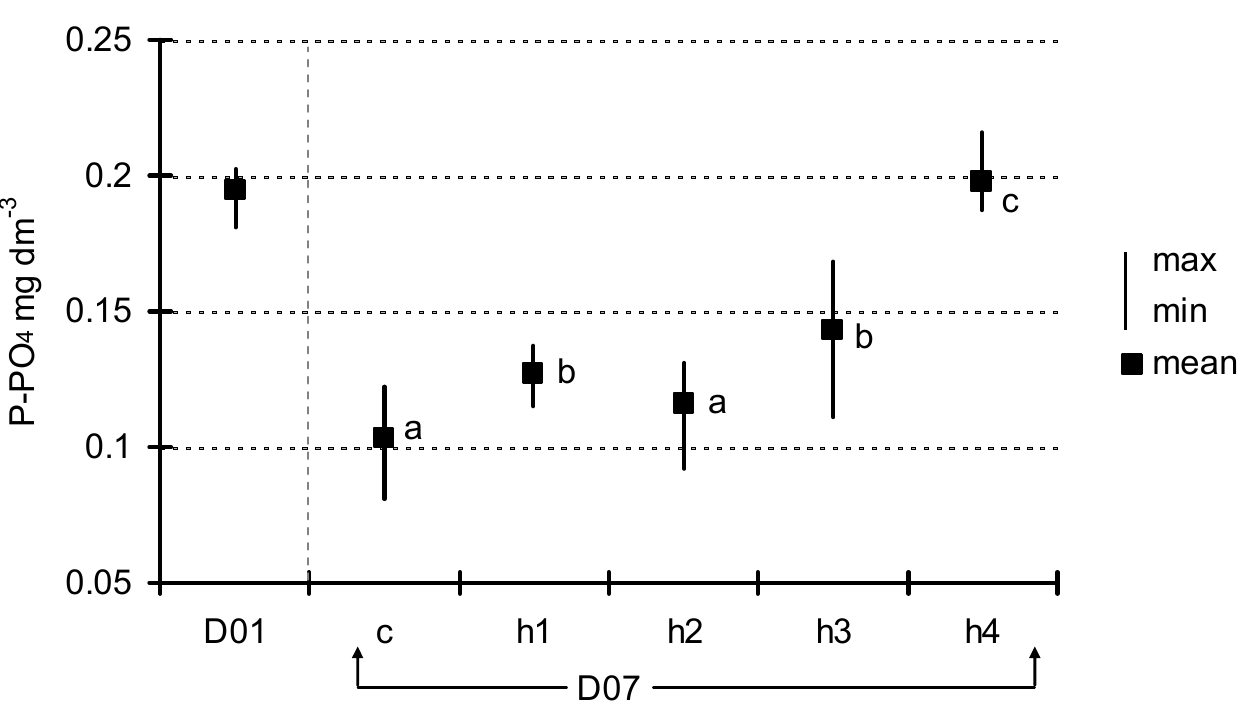
Figure 5. Change in P-PO 4 concentration between D01 and D07 (means with the same letters did not differ significantly; post hoc Duncan’s test at p < 0.05).